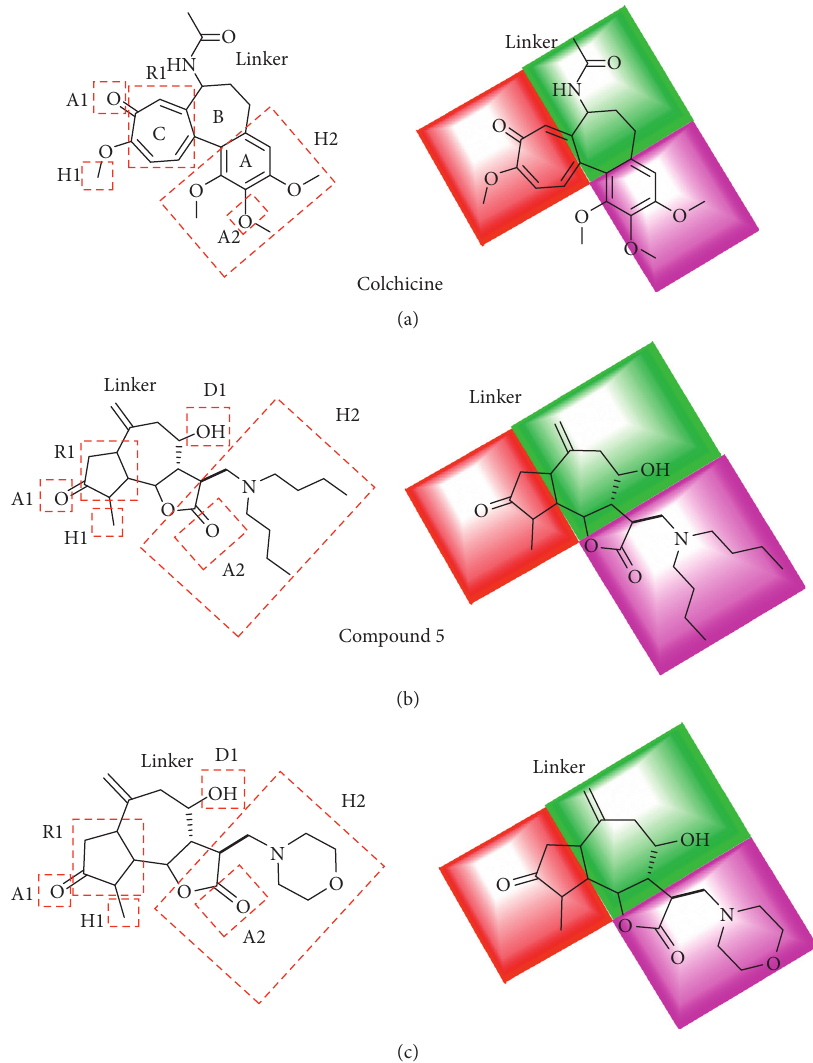
Figure 5: Essential pharmacophoric features of colchicine, compounds 2 and 5 as CBSIs.